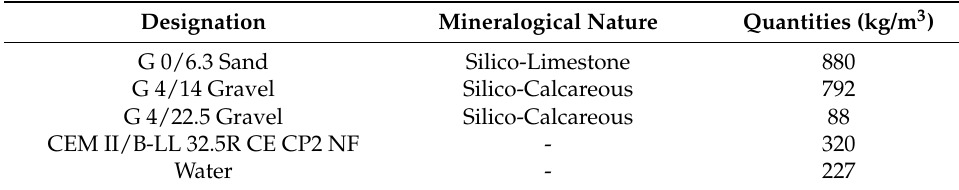
Table 1. Composition of concrete used for casting of